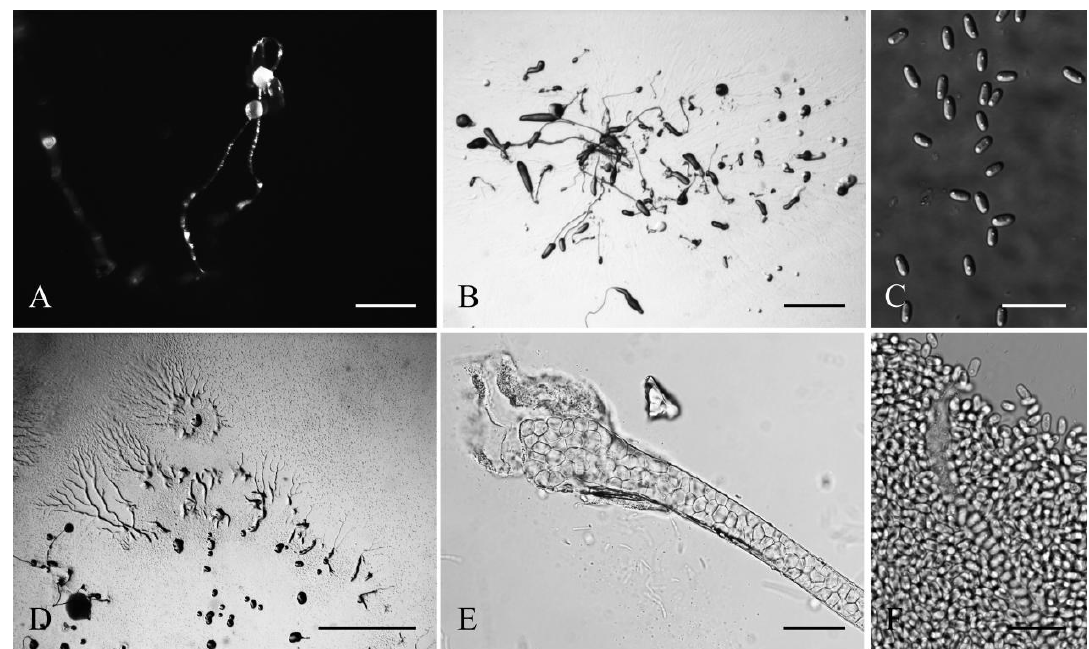
Figure 5. Morphological features of Cavenderia protumula (TH20A). ( A ), Sorocarps. ( B ), Clustered pseudoplasmodia. ( C ), Spores. ( D ), Aggregations. ( E ), Sorophore base. ( F ), Sorophore tip. Bars: ( A )